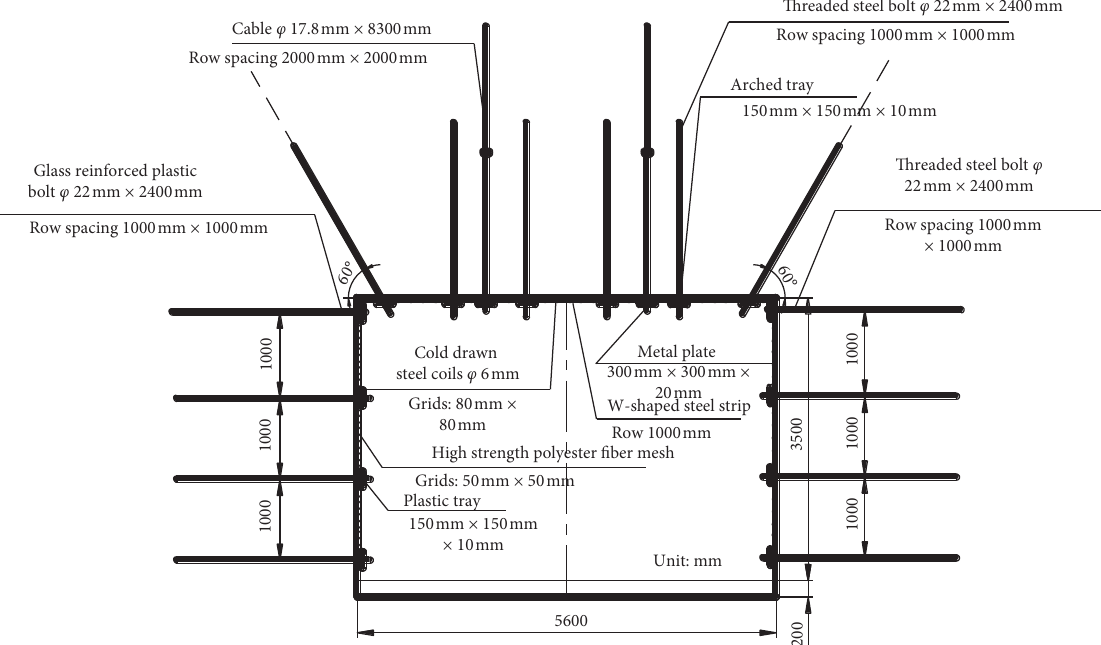
Figure 12: Supporting section diagram of 2205 transportation